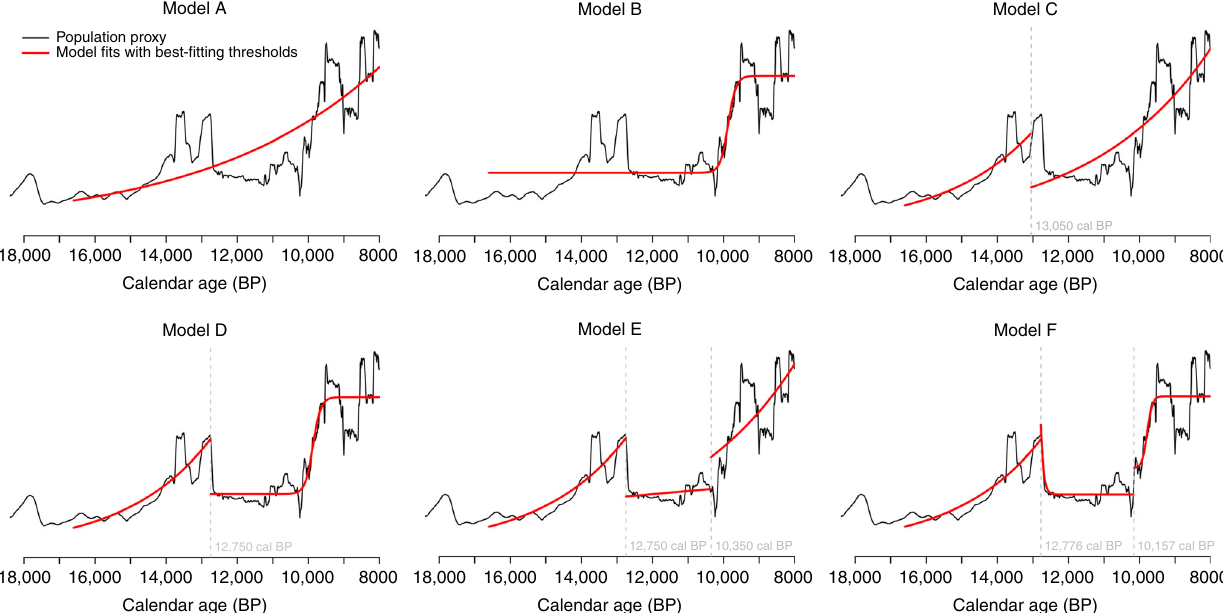
Fig. 4 Demographic models tested using an information-theoretic based model selection approach. The black curve depicts the empirical SPD population proxy whereas the red curves represents the model fi ts with best fi tting thresholds for each model. The vertical gray dashed lines represent the highest likelihood breakpoint